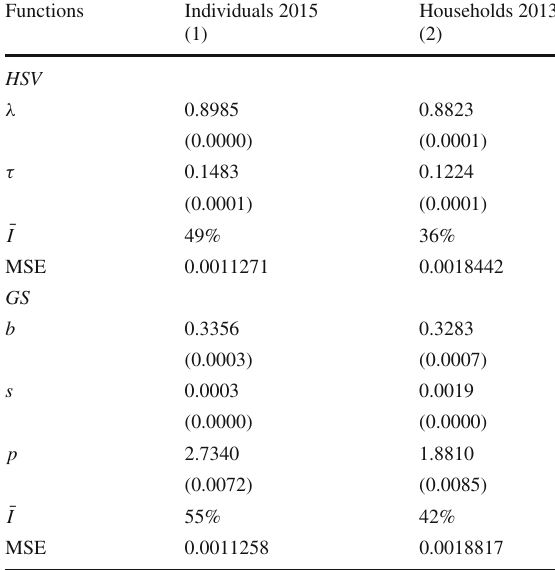
Table 10 Parametric estimates of the average tax